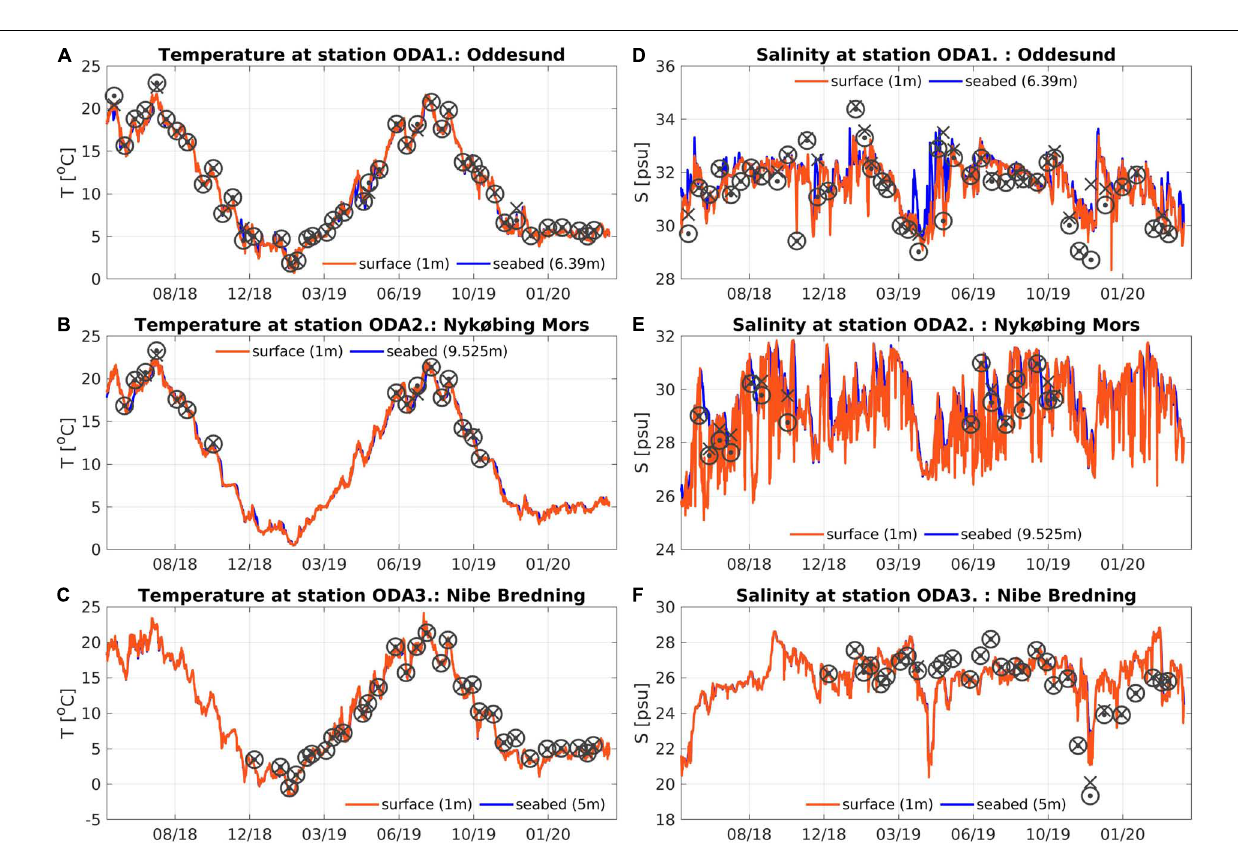
FIGURE 10 | Time series of simulated and observed values of water temperature and salinity in the surface (A–C) and bottom (D–F) at station ODA1 (A,D) , ODA2 (B,E) , and ODA3 (C,F) in Figure 1 . Observed values at the surface are shown as black circles with dots, whereas observed values near the sea bed are shown a